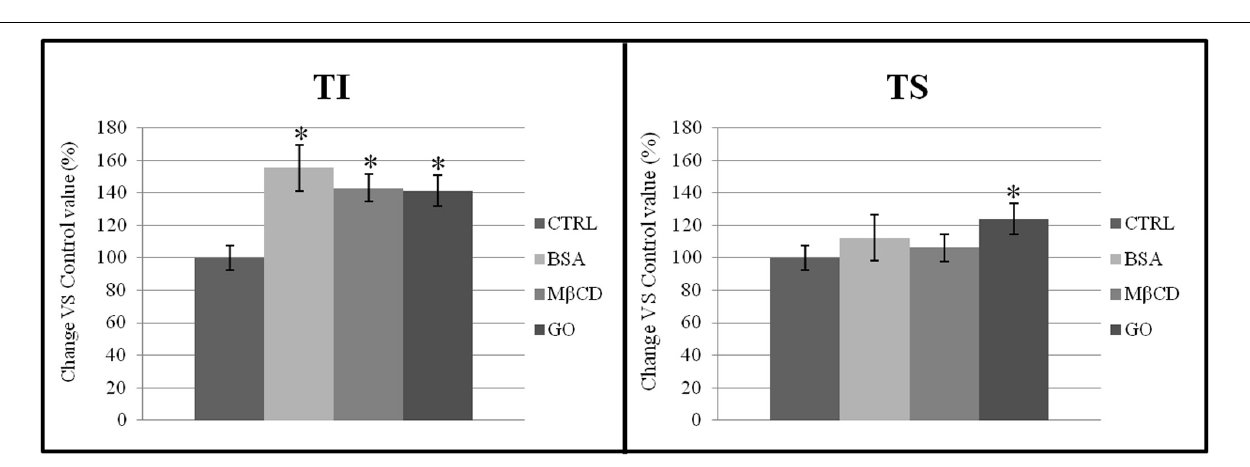
FIGURE 6 | Percentage distribution of proteins in TI and TS fractions, isolated from a membrane-enriched fraction (MEF) prepared from sperm incubated in a capacitating medium (BSA, M β CD, GO treatments) or from sperm collected in a non-capacitating medium (CTRL). The data reported were expressed as percentage change relative to control value. Values are the mean of three protein determinations ± SE obtained from three independent experiments. * P < 0.05 versus